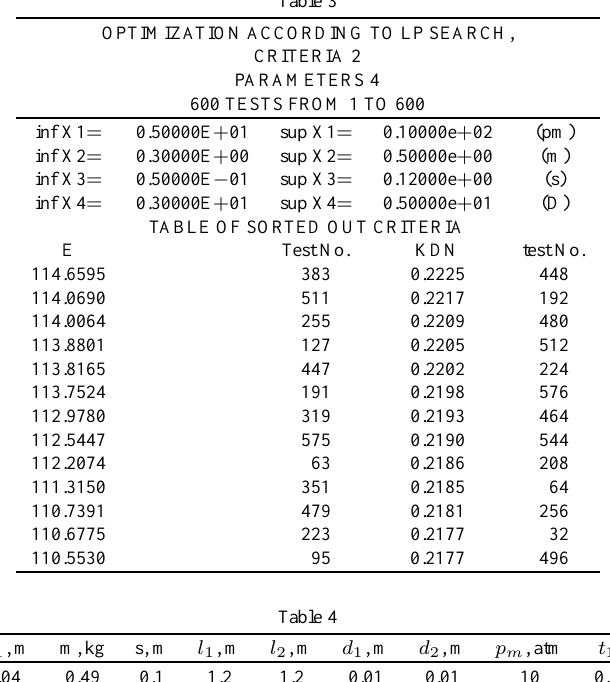
OPTIMIZATION ACCORDING TO LP SEARCH, CRITERIA